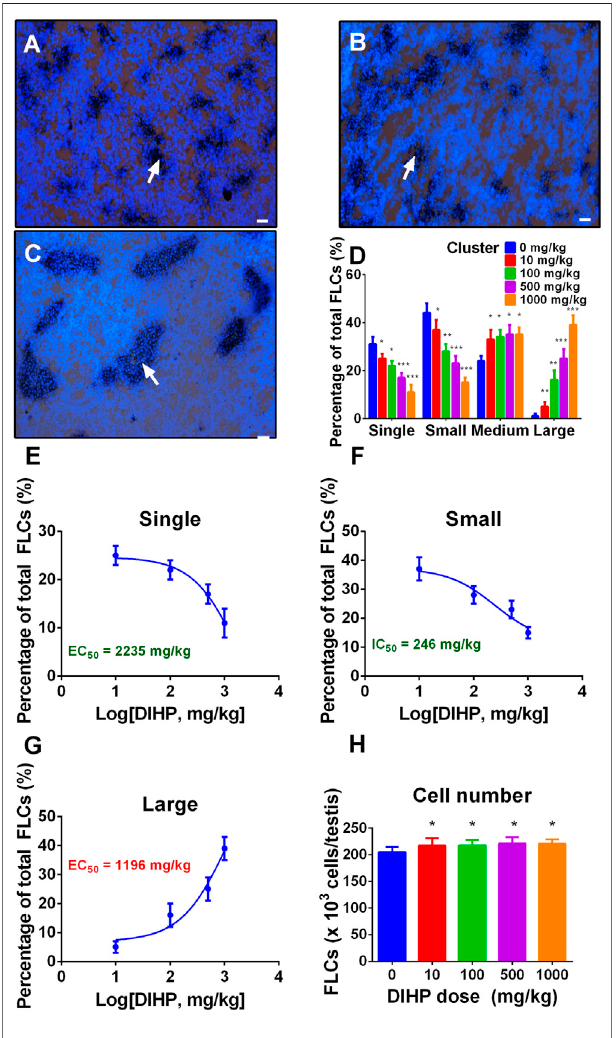
FIGURE 1 | Effect of diisoheptyl phthalate (DIHP) on the distribution and cell number of fetal Leydig cells (FLCs). Representative micrographs of testicular slices of 0 (A) , 100 (B) , and 1,000 (C) mg/kg DIHP. Scale bar (cid:1) 50 μ m. White arrows point to a bunch of fetal Leydig cells. Group (D) , Fetal Leydig cell allocation; Panel (E – G) , IC 50 or EC 50 values are used for single, small, and large fetal Leydig cell clusters; Panel (H) , Fetal Leydig cell number; data expressed as mean ± SEM, n (cid:1) 6; * p > 0.05, ** p < 0.05, *** p < 0.01 indicate that the signi fi cant level between the DIHP group and the control group, respectively.